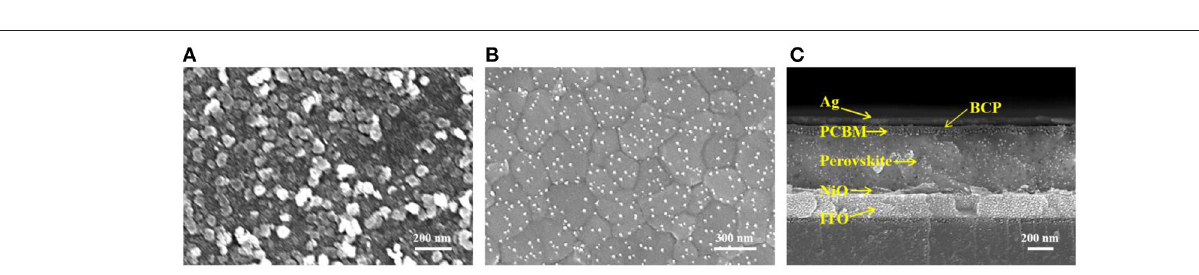
FIGURE 1 | XRD patterns of the (A) NiO x NCs and (B) triple cation perovskite.